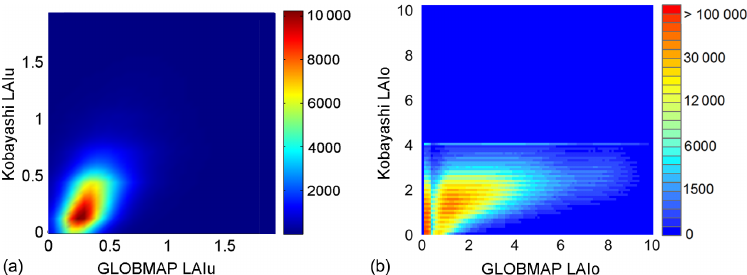
Figure 8. Comparison between the GLOBMAP LAI o and LAI u with the Kobayashi datasets (Kobayashi et al., 2010) over the larch forest region in eastern Siberia: (a) understory LAI and (b) overstory LAI.